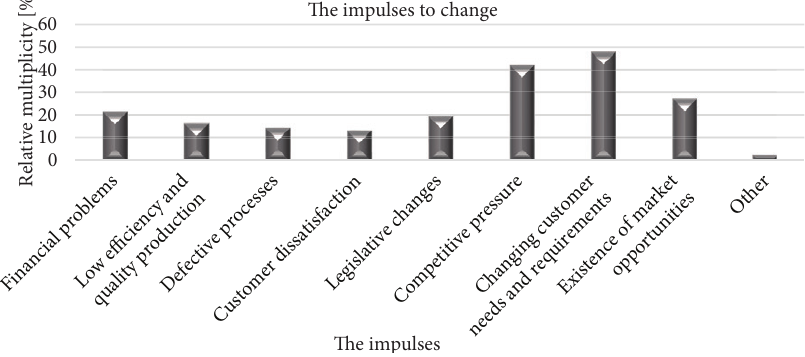
Figure 3. Impulses to change (source: own processing)